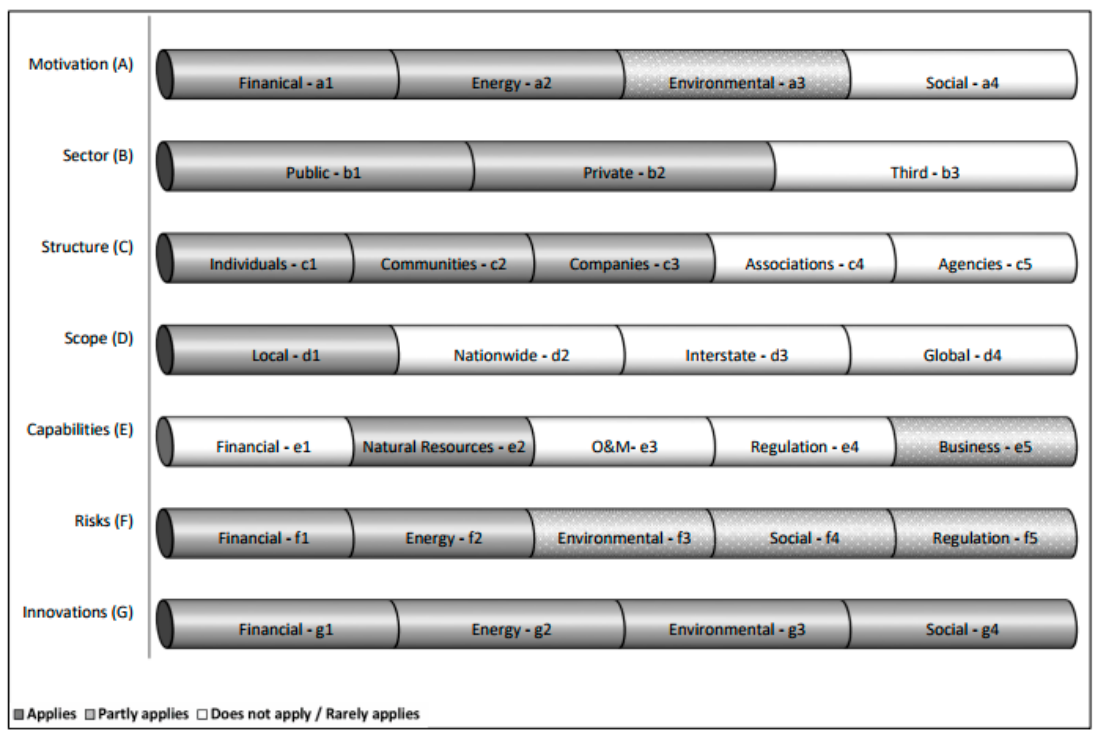
Figure 5. Schematic profile of German self-consuming entrepreneurs.